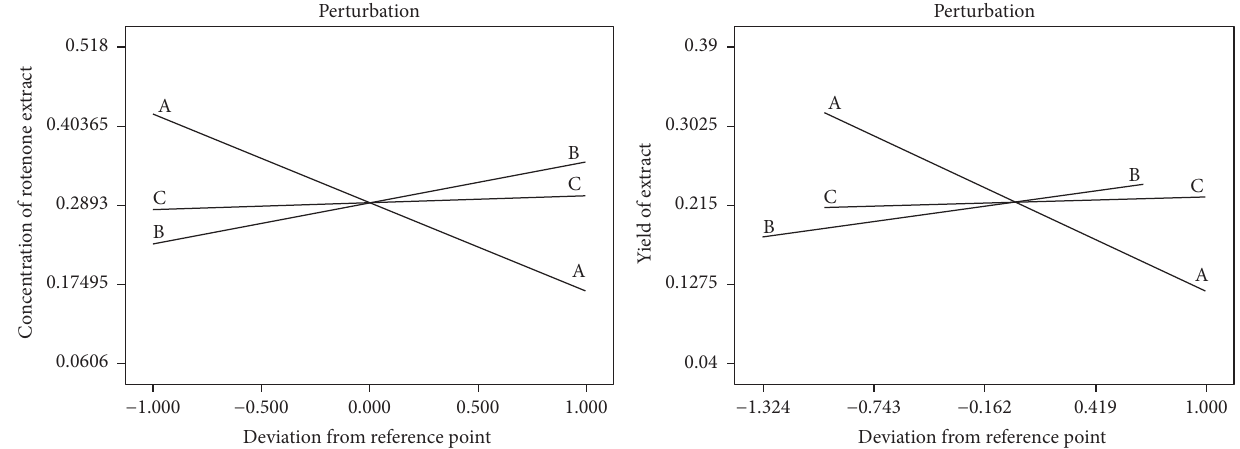
Figure 7: Perturbation plot of independent variables (A: solvent ratio; B: extraction time; C: agitation rate) and response variables (rotenone yield and